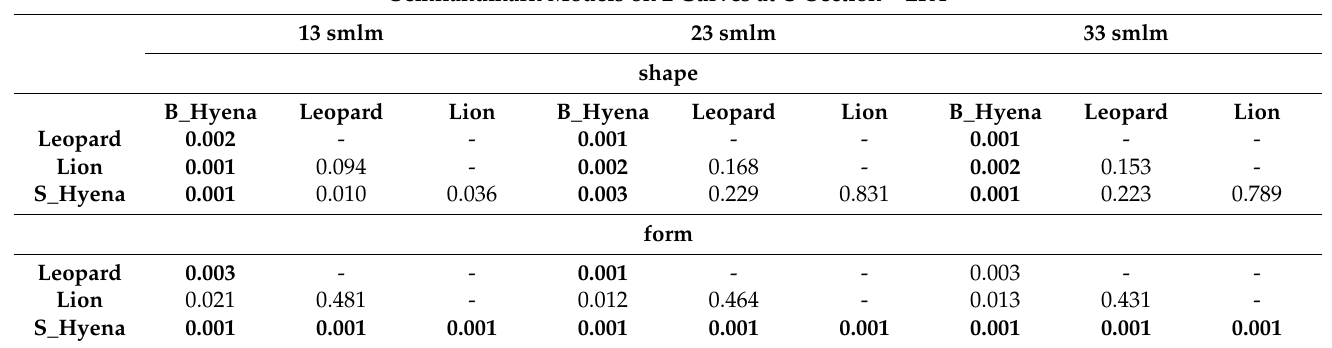
Table 7. MANOVA p -values obtained on the 13, 23, and 33 semilandmark (smlm) models on two curves used to describe the most conspicuous U cross-sections of the carnivore scores, using an EFA approach. Statistical significance ( p < 0.003) is marked in